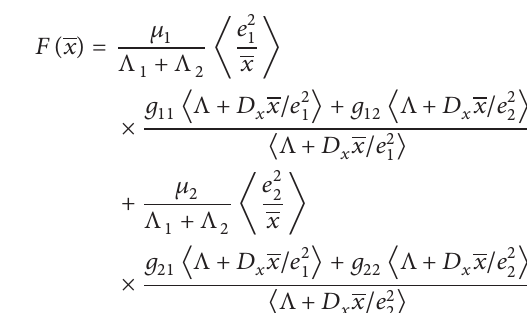
> 1 . In this case, the DFE is unstable. 0